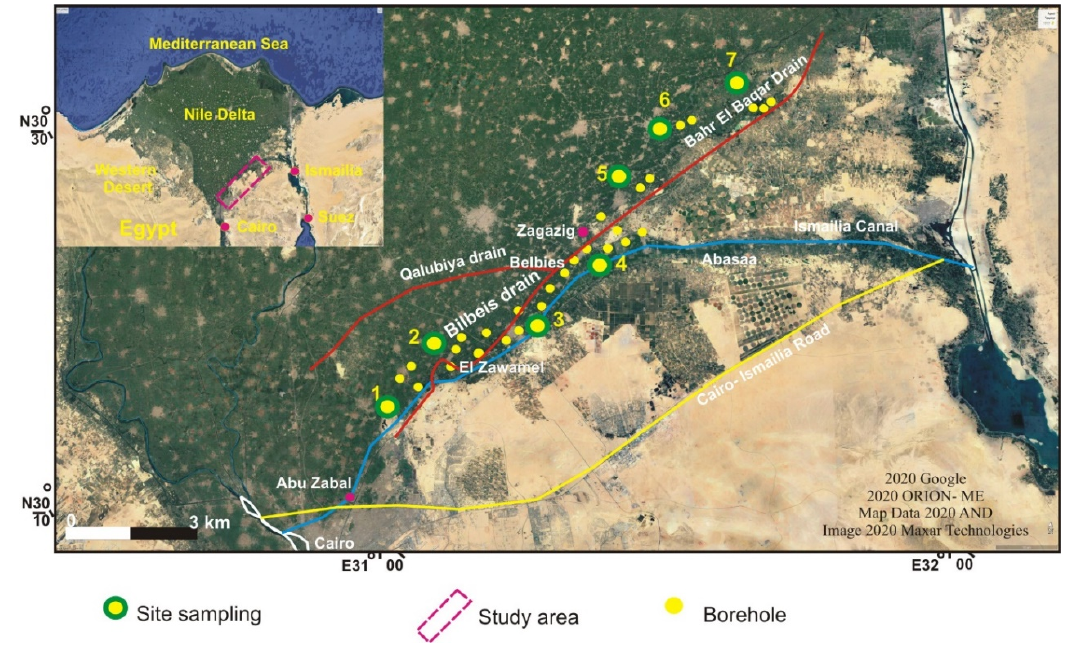
Figure 2. Location map of the study area showing the 7 study sites and the 28 drilled boreholes.